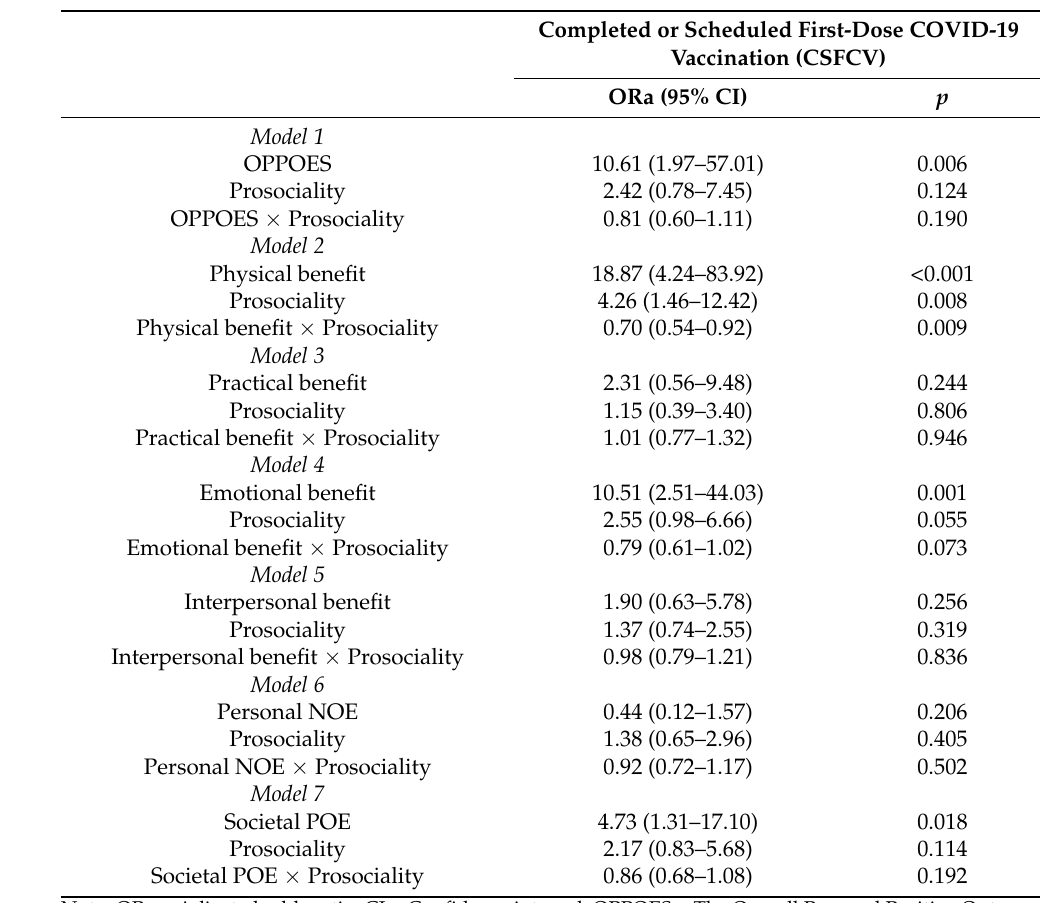
Table 3. Moderation analysis testing the moderation effect of prosociality between personal/societal outcome expectancies and CSFCV (n =